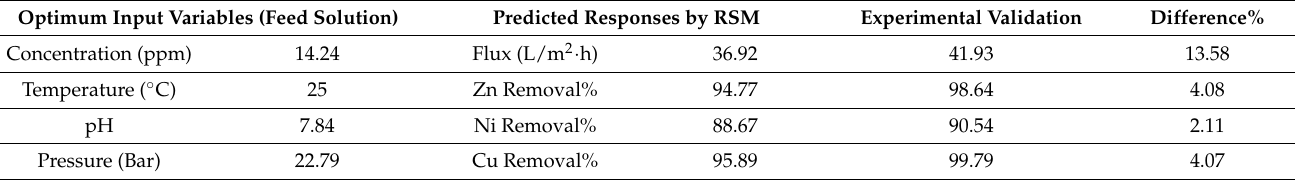
Table 4. NF Optimization of response through